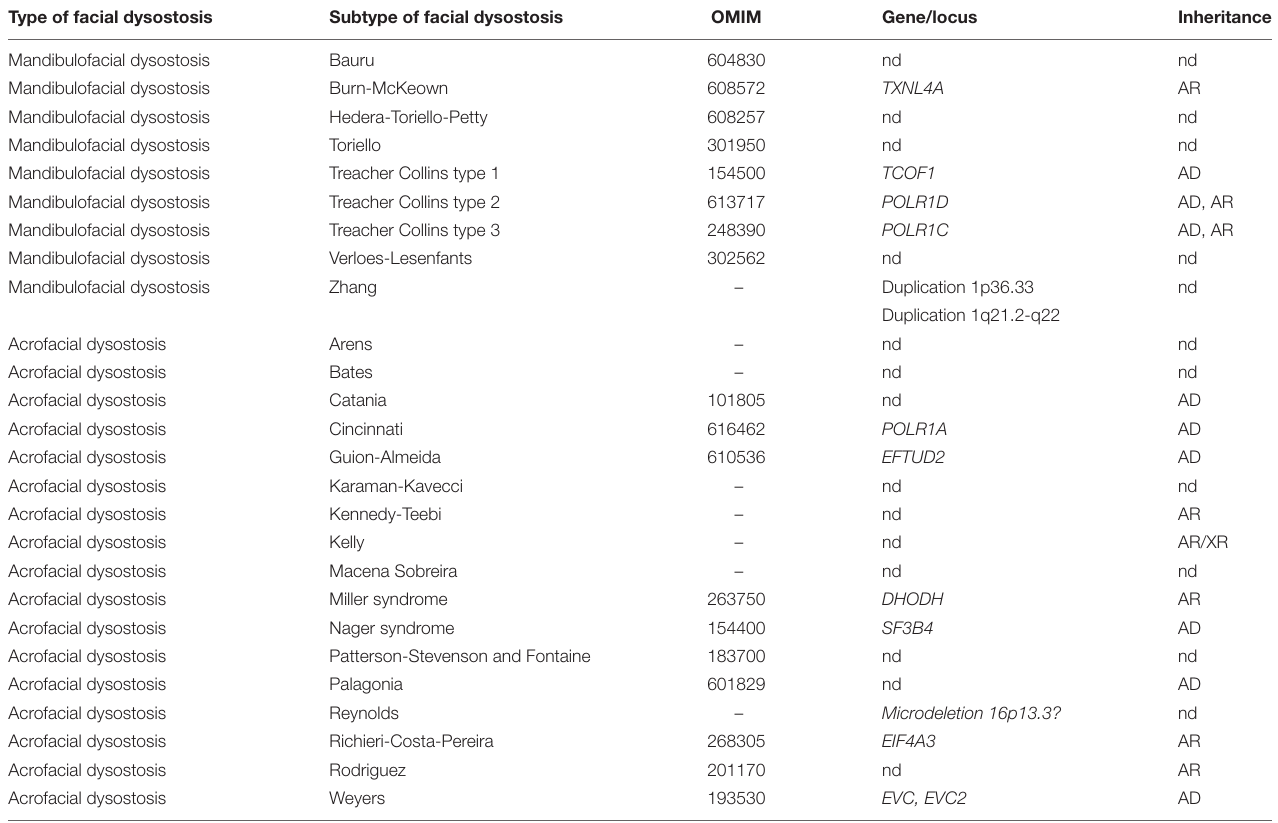
TABLE 1 | Clinical classification of human facial